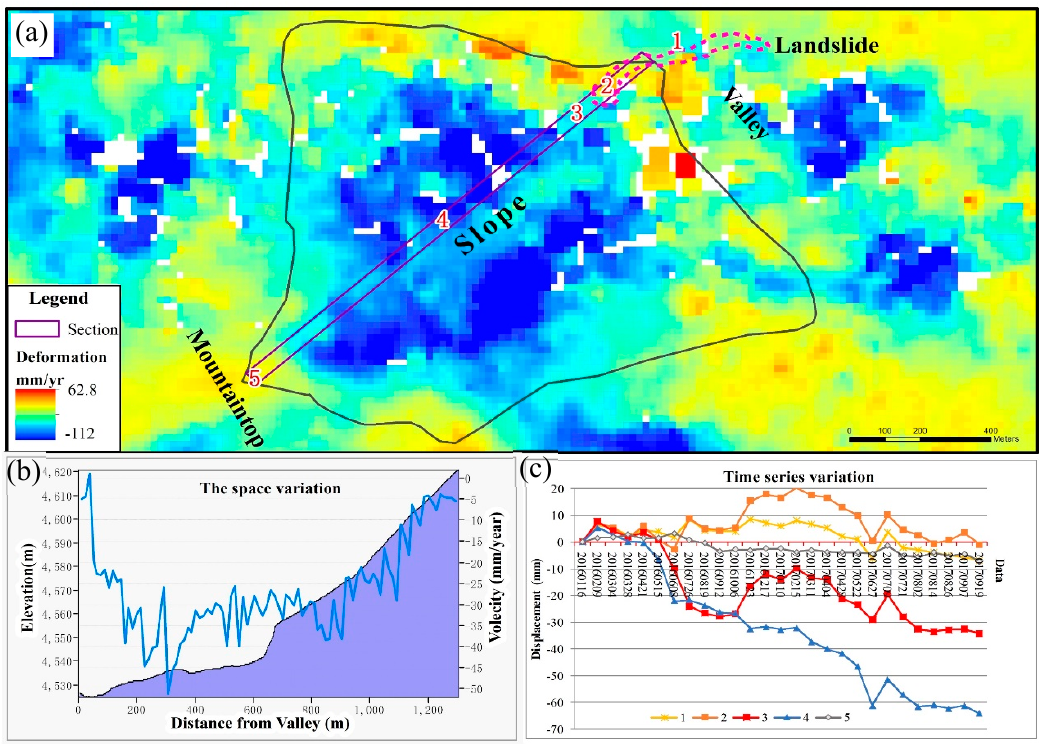
Figure 4. Deformation (a) acquired from InSAR in (b) space and (c) time. The purple rectangle represents the section area (about 1300 m long, 40 m wide) from the valley to the mountaintop; the red line represents the landslide. Point 2 and 3 were the same as P1 and P2 in Figure 1c, respectively.